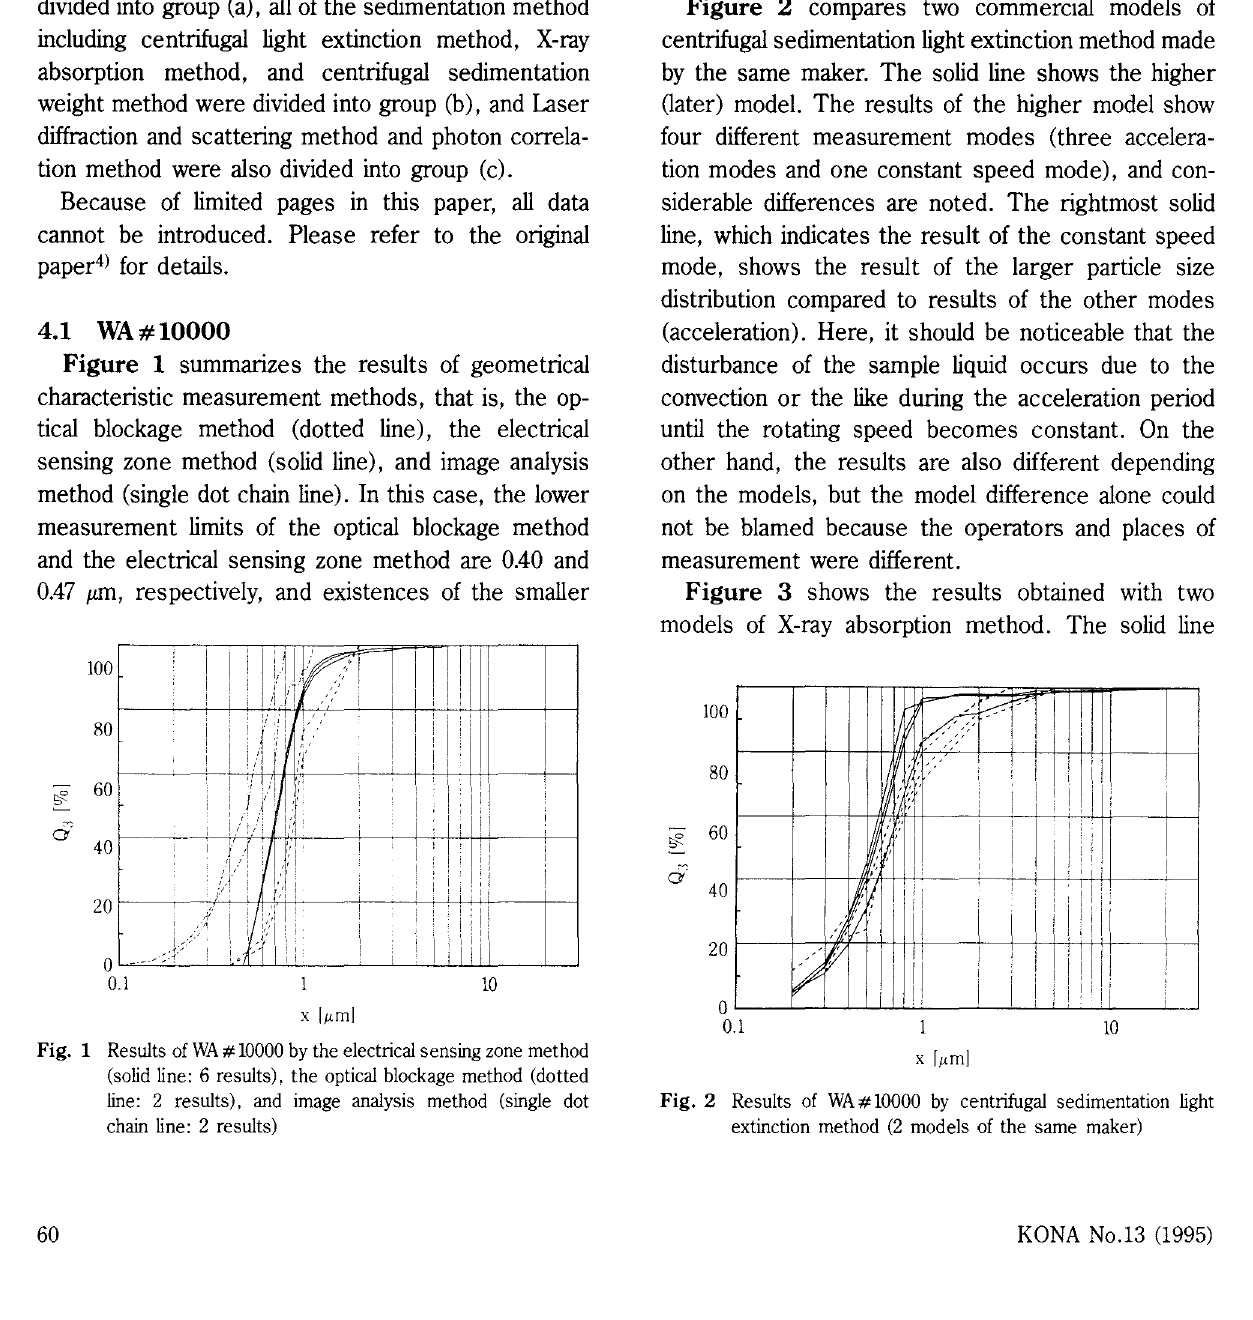
Fig. 1 Results of WA # 10000 by the electrical sensing zone method (solid line: 6 results), the optical blockage method (dotted line: 2 results), and image analysis method (single dot chain line: 2 results)